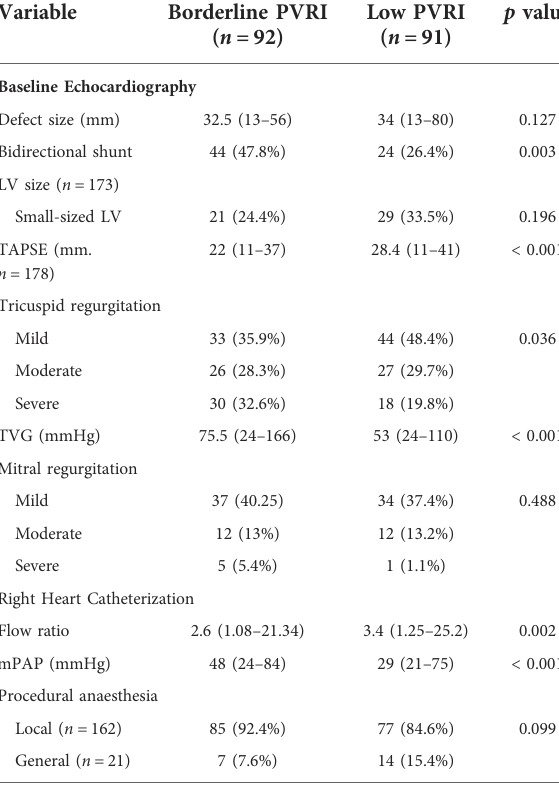
TABLE 1 Baseline characteristic of 183 secundum ASD patients who underwent surgical closure.